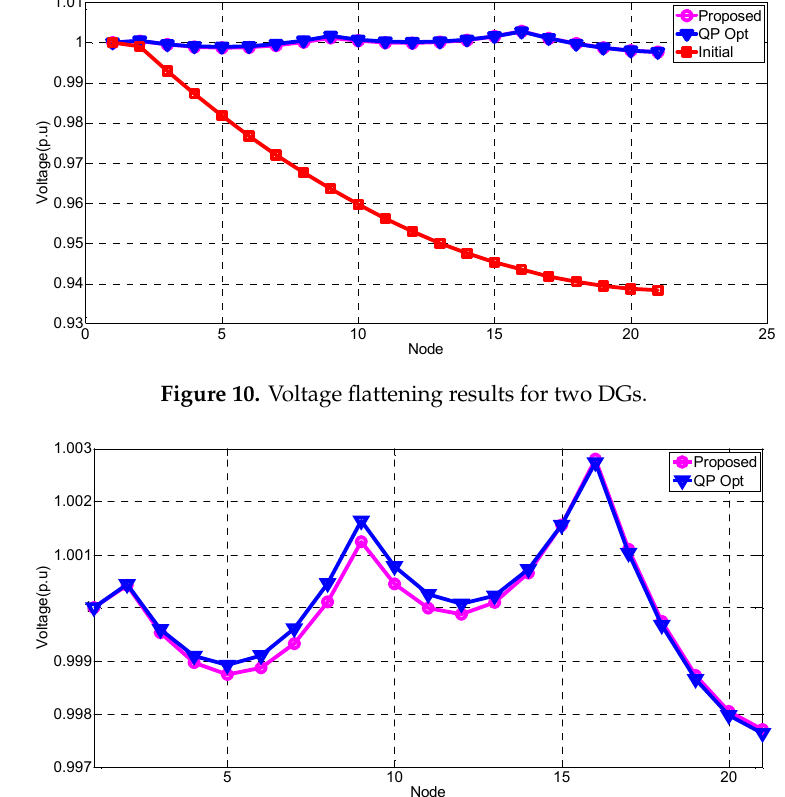
Figure 11. Enlarged comparison of voltage flattening results.